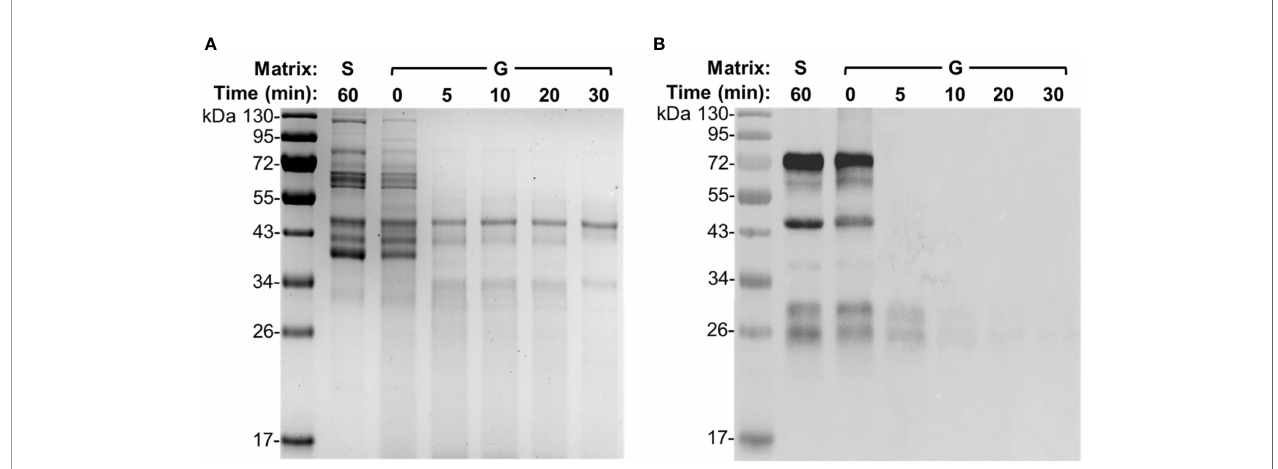
FIGURE 4 | Degradation dynamics of egg yolk IgY in gizzard content. (A) SDS-PAGE and (B) immunoblotting analyses of the integrity of egg yolk IgY in response to the treatment with a representative gizzard content at 42°C for the indicated length of time. The reconstituted hyperimmune egg yolk powder was used as stock to spike the gizzard content matrixes as described in the Materials and Methods . The far left lane is a protein marker. Abbreviation of the matrix system for treating egg yolk IgY: S, saline; G, gizzard content.